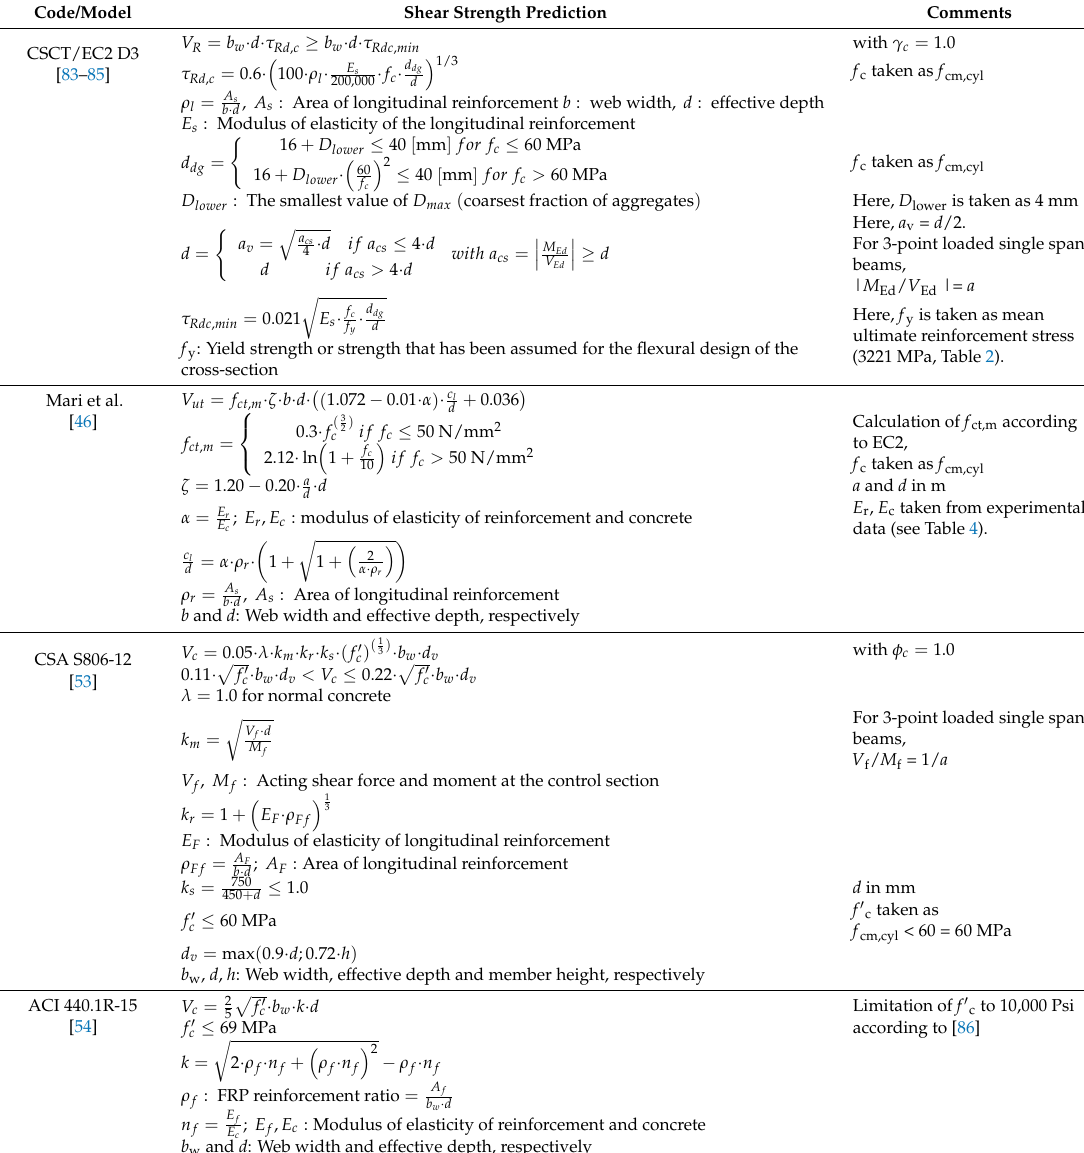
Table 5. Summary of design provisions and models used in the